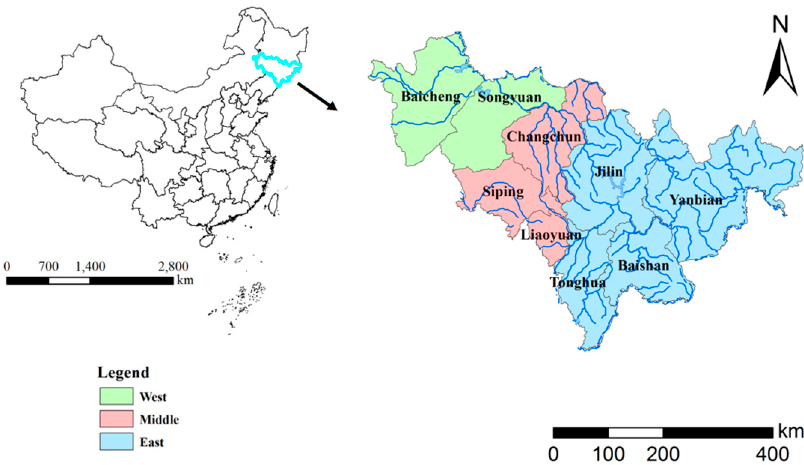
Figure 1. Location of Jilin Province and the names of its nine prefectures.